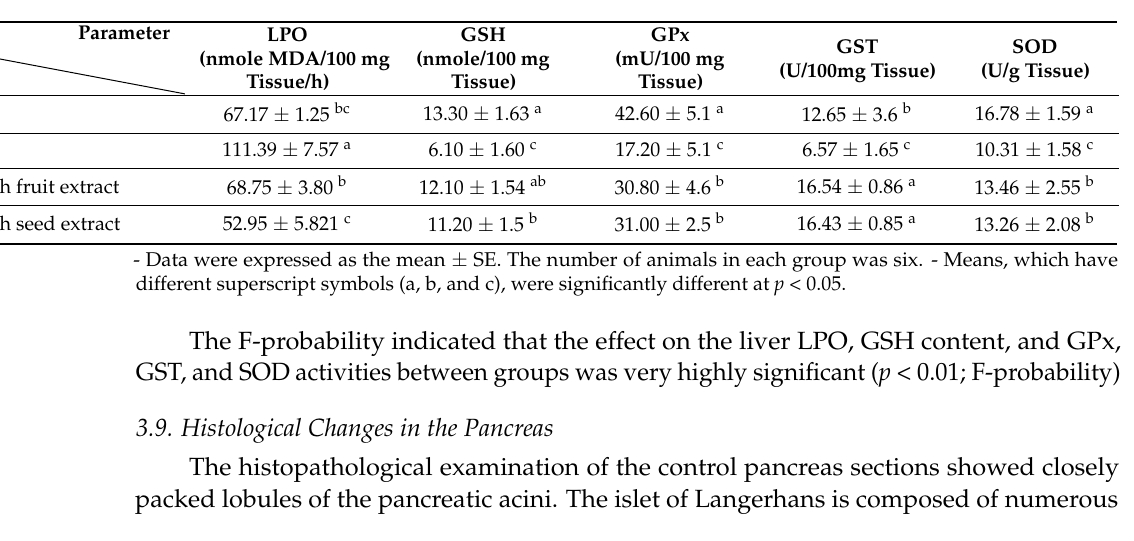
Table 7. Effects of the B . aegyptiaca fruit and seed extracts on liver LPO, GSH content, and GPx, GST, and SOD activities in NASTZ-induced diabetic